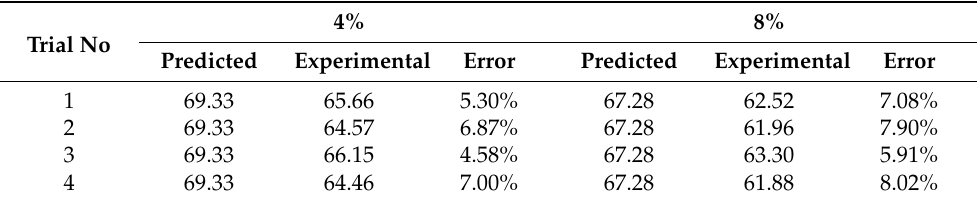
Table 6. The predicted and experimental MRR (mg/min) at optimum conditions. Trial